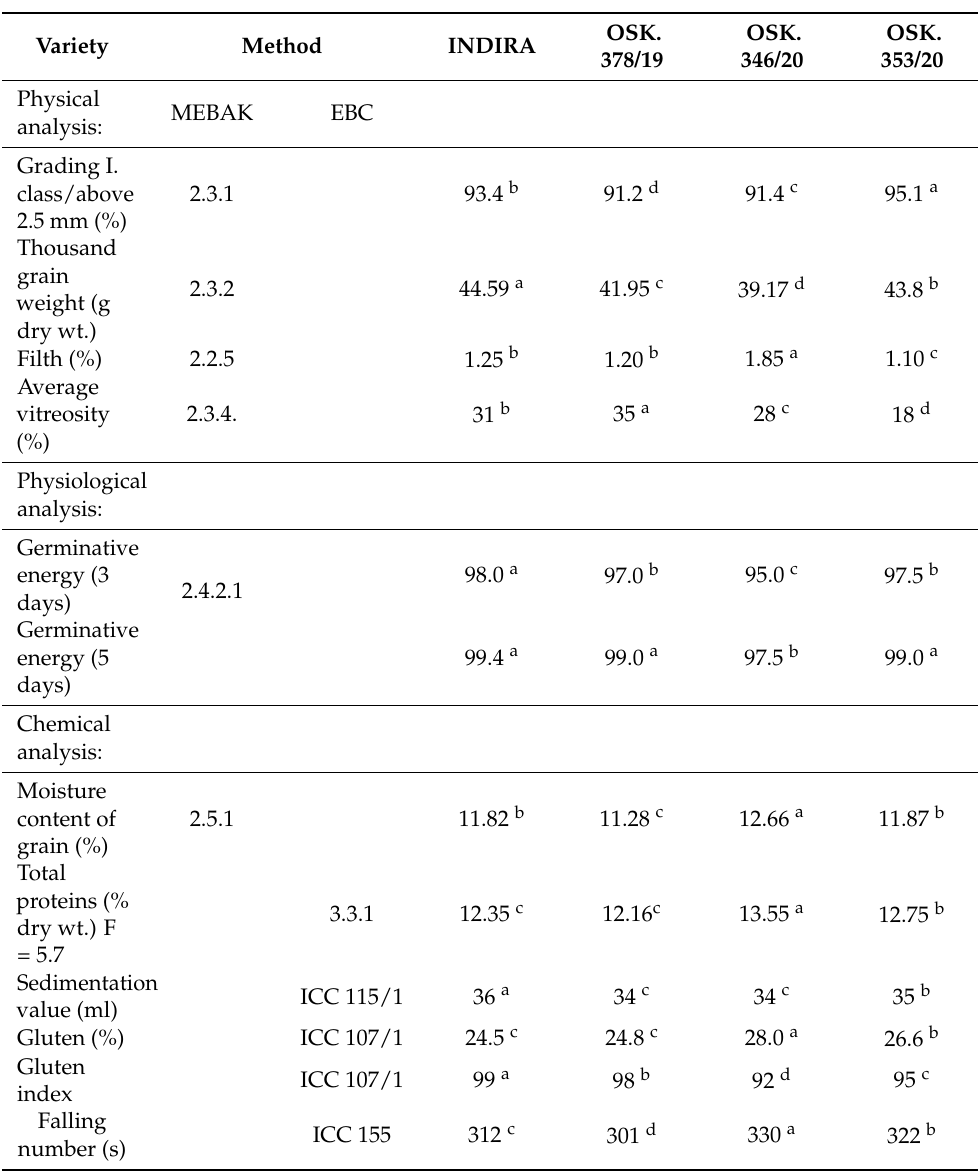
Table 3. Quality characteristics of the used wheat varieties (harvest 2019). Variety Method INDIRA